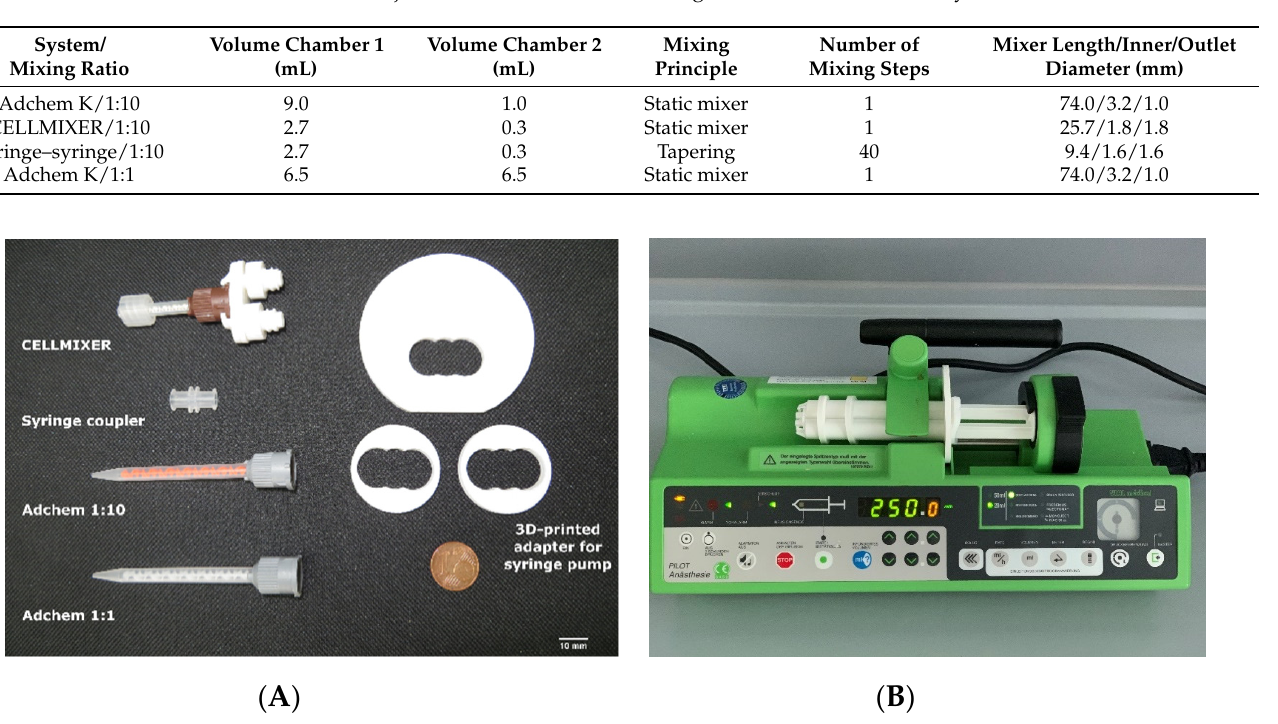
Table 1. Major characteristics of the mixing devices used in this study.